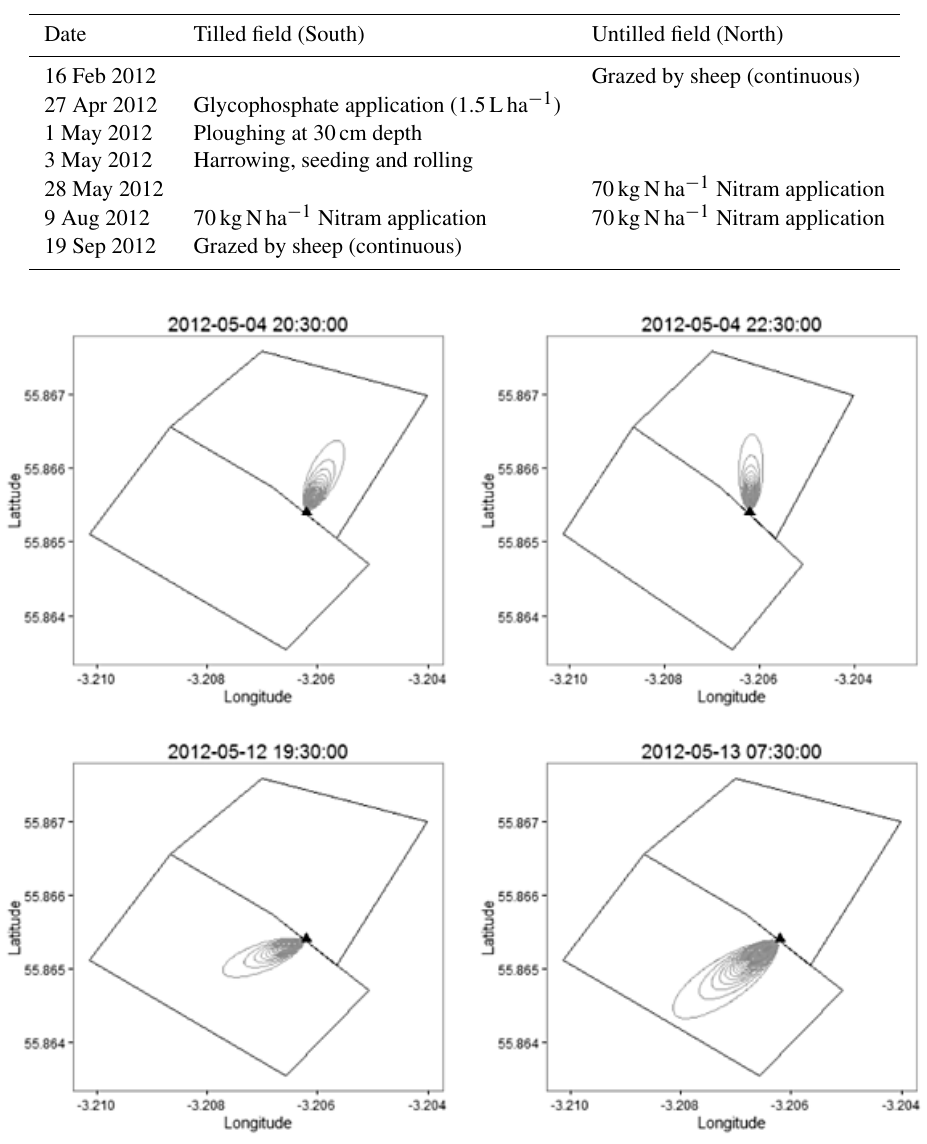
Figure 2. Four example flux footprints, with contours showing the relative contribution to the measured eddy covariance flux, based on the model of Kormann and Meixner (2001). Half-hourly flux data were only included if 97.5% of the measured flux was attributed to either the untilled (top) or tilled (bottom)